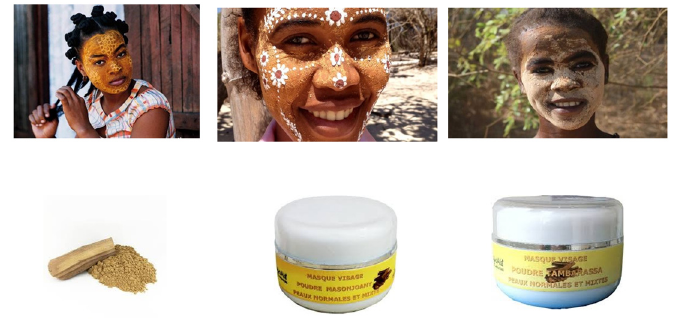
Figure 9. Face mask and commercially available Masonjoany products. Upper Panel, from left to right. Two Masonjoany tattoo-like facial decorations on young Malagasy women. The third example to the right is intended as a more traditional full mask protecting from solar irradiation. In this case the reader can observe how the creamy preparation becomes brittle as a consequence of rapid drying. Lower Panel, from left to right. Masonjoany powder obtained by grating the wood with a coral stone. Two jars of commercial sun protective screens.